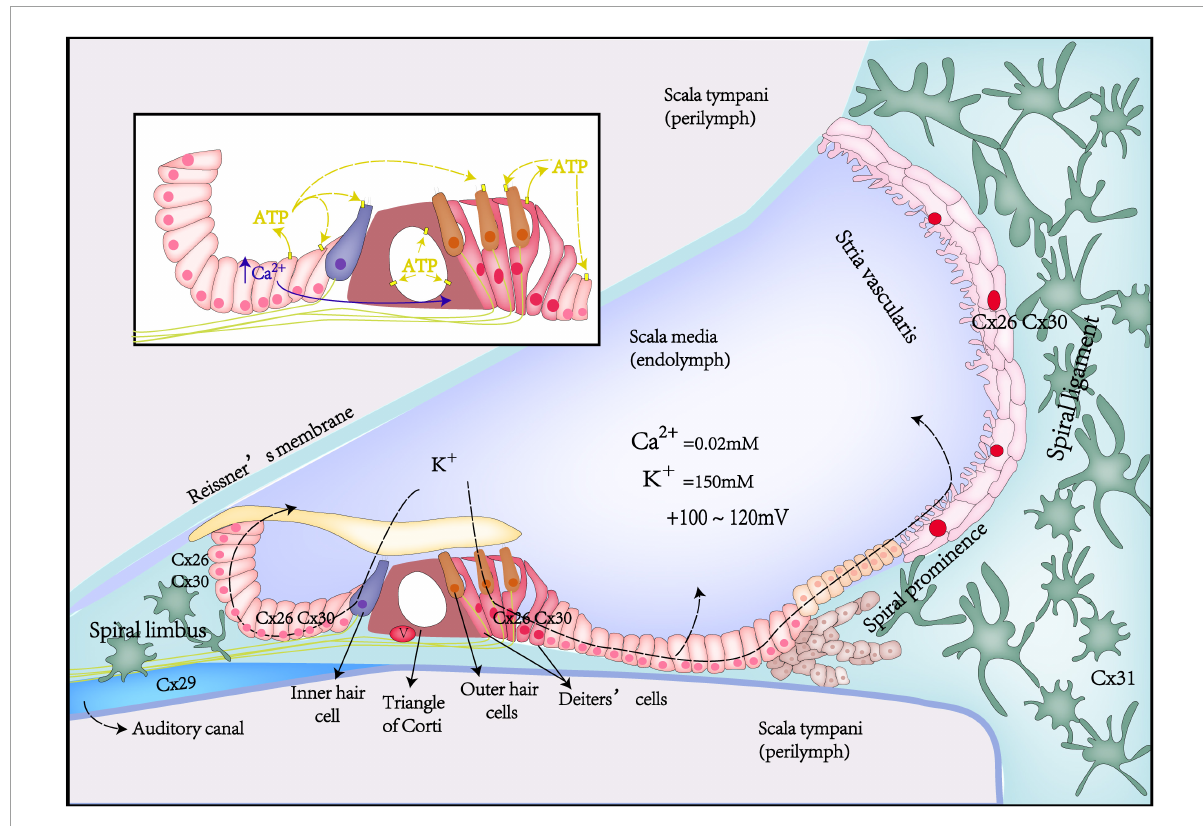
FIGURE1 Schematic diagrams of Cx expression, potassium recycling, and ATP-Ca 2 + signaling in the inner ear.